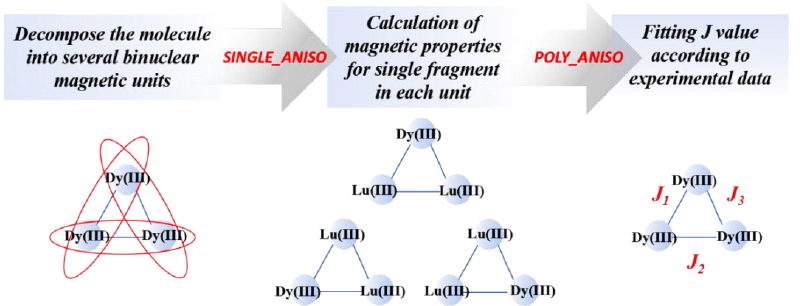
Figure 8. Simple flow chart on magnetic exchange calculation steps. A trinuclear dysprosium compound is attached to explain that specifically. The antimagnetic ions Lu(III) are applied to replace other Dy(III) ions in the calculation for the mononuclear magnetic properties.